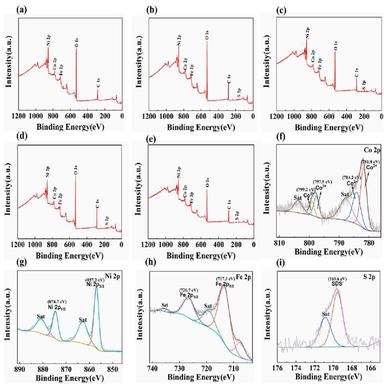
XPS survey spectra of CoNiFe–LDH (a), CoNiFe(SDS)–LDH (b), CB/CoNiFe(SDS)–LDH (c), CNTs/CoNiFe(SDS)–LDH (d), CNFs/CoNiFe(SDS)–LDH (e) and high-resolution XPS spectra of CNFs/CoNiFe(SDS)–LDH, Co 2p (f), Ni 2p (g), Fe 2p (h) and S 2p (i).